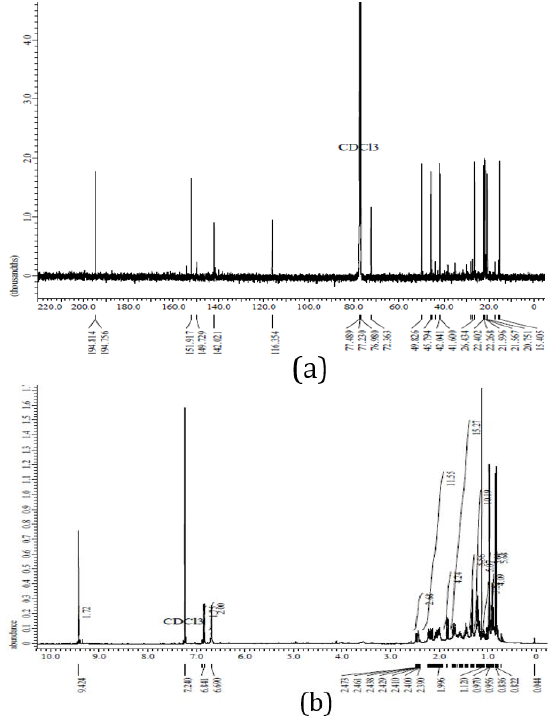
Figure 2. 13 C-NMR spectra and H-NMR spectra (CDCl 3 , 500 MHz) of compound 1